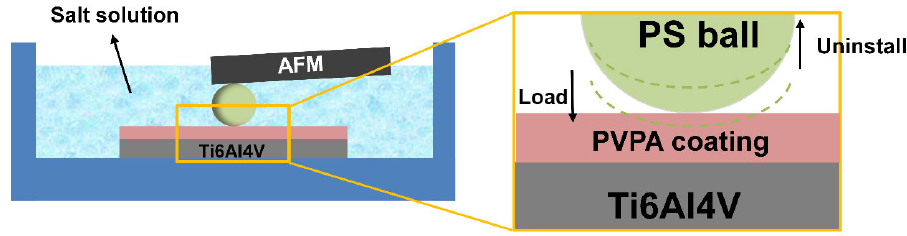
Fig. 6 Schematic diagram of the AFM-submerged experiment measuring the adhesion between PVPA-modified Ti6Al4V and PS